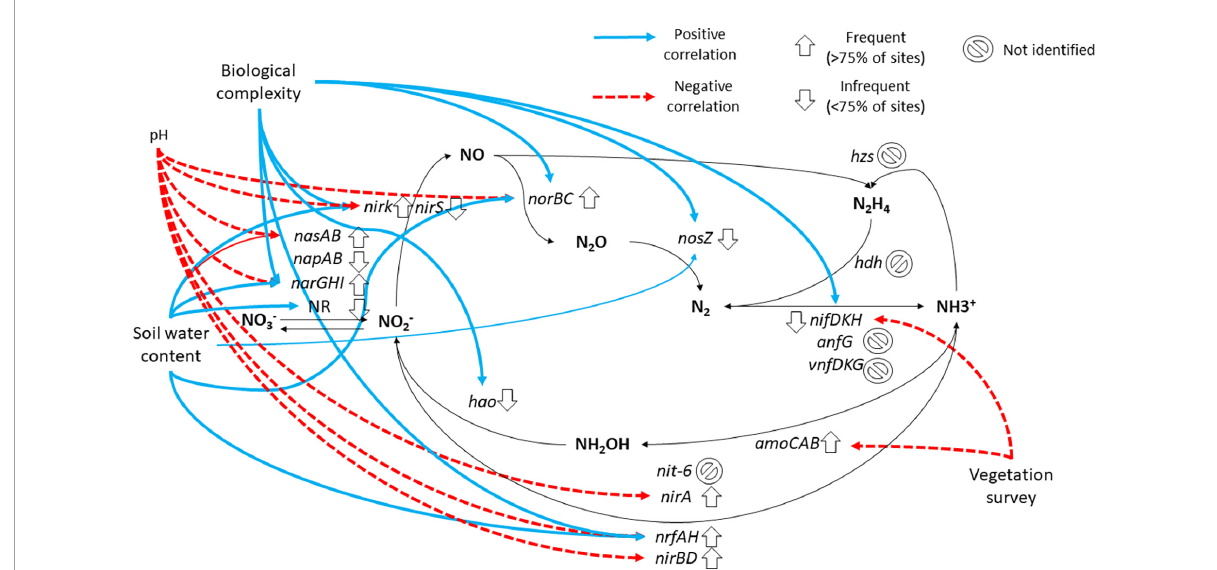
FIGURE7 Schematic representation of nitrogen cycle, with implicated genes and summary of relevant biogeochemical variables. Chemical compounds in bold. Black arrows indicate the direction of the reactions of oxidation and reduction. The up arrows indicate that at least one gene of the operon was identified in at least 75% of sites, while the down arrows indicate the opposite (identified in less than 75% of sites). Genes that were not identified in any metagenome have a circular sign. Important correlations and associations between biogeochemical variables (biological complexity, pH, soil water content, vegetation survey) and specific genes were depicted with blue with continuous line (positive) and red with discontinuous line (negative) arrows. Reactions and genes based on Table 1